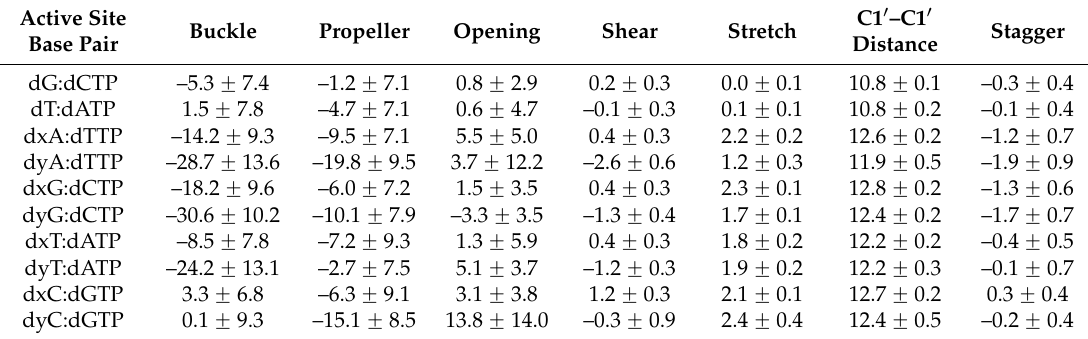
Table 3. Averages and standard deviations of the base-pair parameters during 40 ns MD simulations